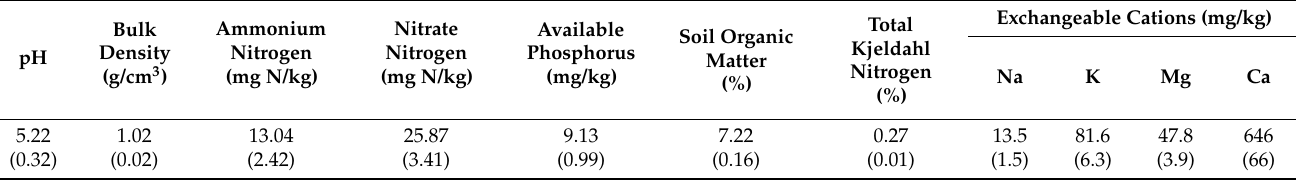
Table 1. The physio-chemical properties of soils on Acacia -dominated slopes (mean ± 1 standard error, N =